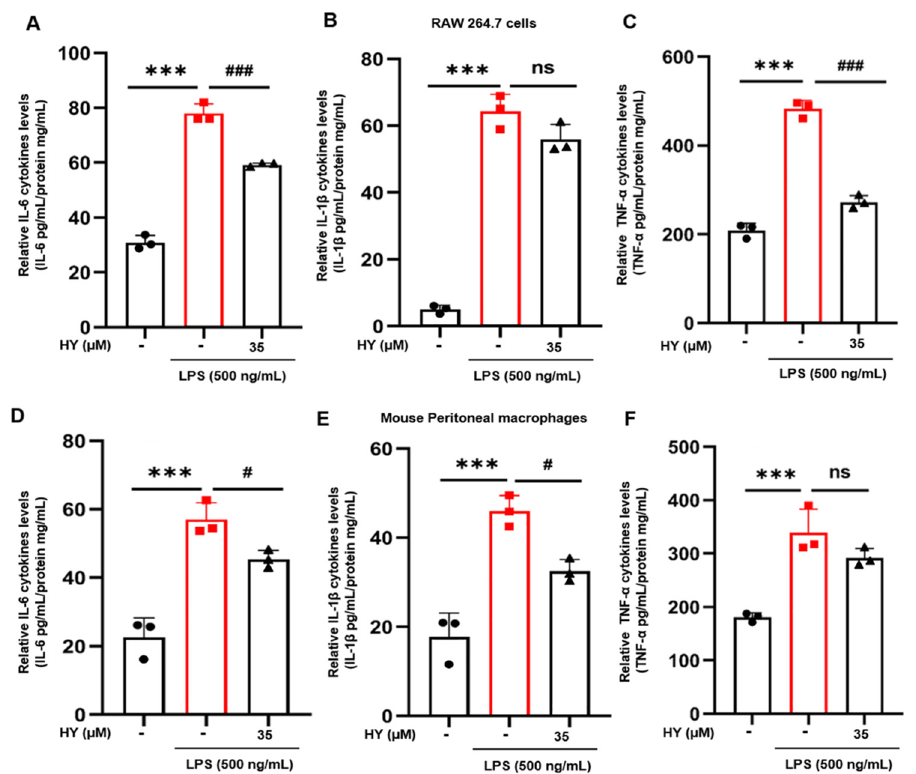
Figure 4. ( A – C ) Enzyme-linked immune sorbent assay (ELISA) for the secreted level of interleukin-6 (IL-6), interleukin-1 β (IL-1 β ), and tumor necrosis factor- α (TNF- α ) in the supernatants of cells treated with HY (35 µM) with 500 ng/mL lipopolysaccharide (LPS) for 24 h in RAW 264.7 cells. ( D – F ) ELISA for the secreted level of IL-6, IL-1 β , and TNF- α in the supernatants of cells treated with 35 µM hyssopuside (HY) with 500 ng/mL LPS for 24 h in mouse peritoneal macrophages. Data are representative of three replicates and shown as mean ± SD. *** p < 0.05 versus the control group; # p < 0.05, ### p < 0.001 versus the LPS-treated group; ns: no significance versus the LPS-treated group.